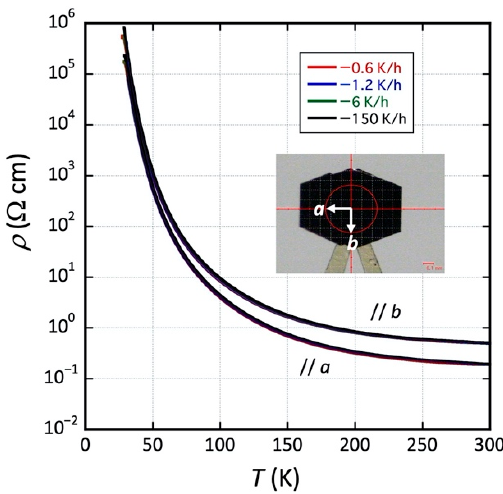
Figure 2. Temperature-dependent resistivities measured along the a axis ( ρ // a ) and the b axis ( ρ // b ) with four different cooling rates for β′ -EtMe 3 Sb[Pd(dmit) 2 ] 2 . The inset is a photo of a single crystal. For both ρ // a and ρ // b , four ρ – T curves (cooling process) overlap almost completely.